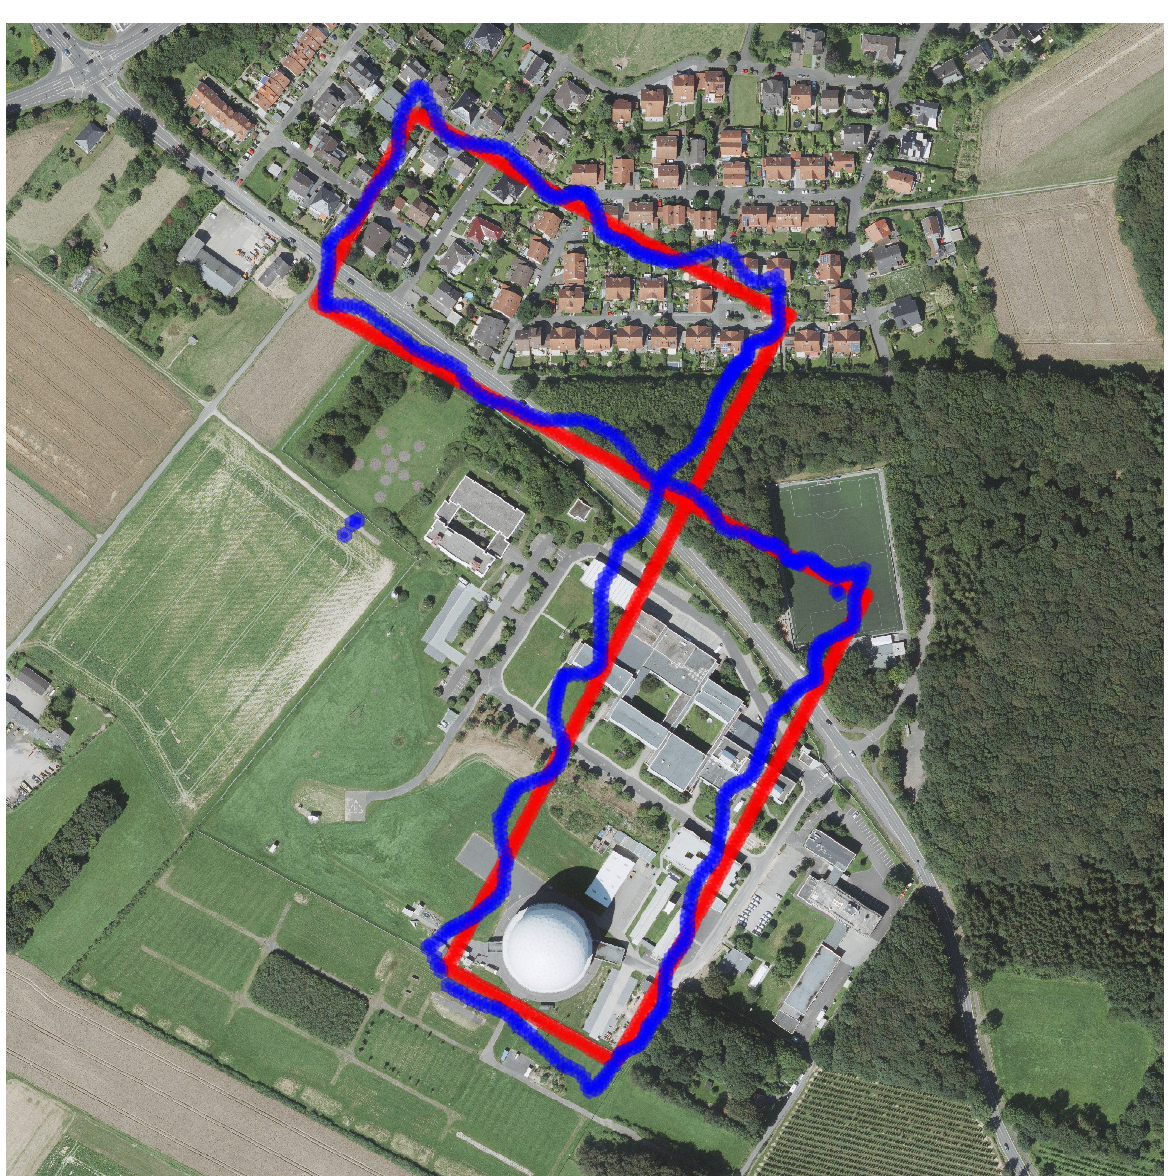
Figure 7. The GPS track of the subset is plotted in red. The corresponding predicted locations are blue. We can see a few outliers to the left of the